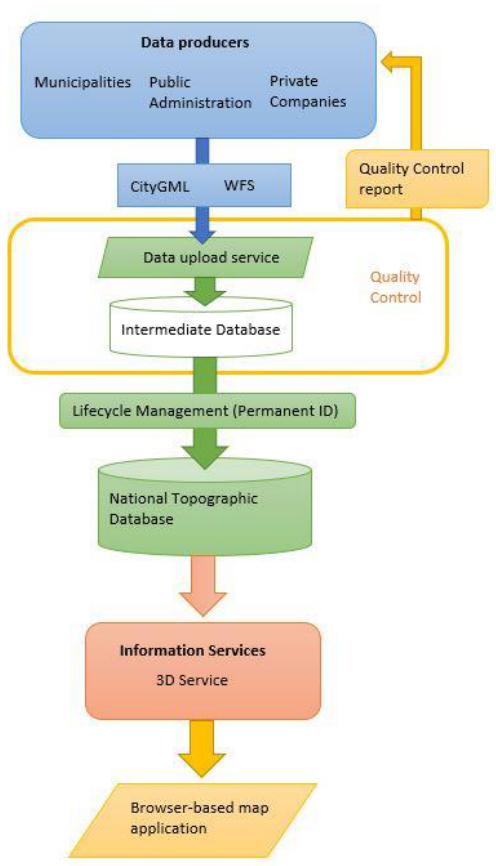
Figure 1 Geospatial Platform